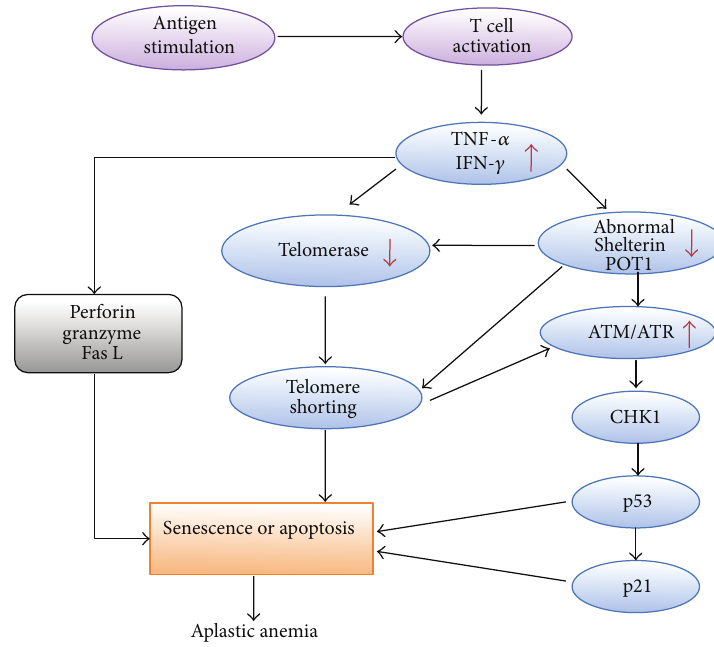
Figure 9: Postulated pathogenesis of aplastic